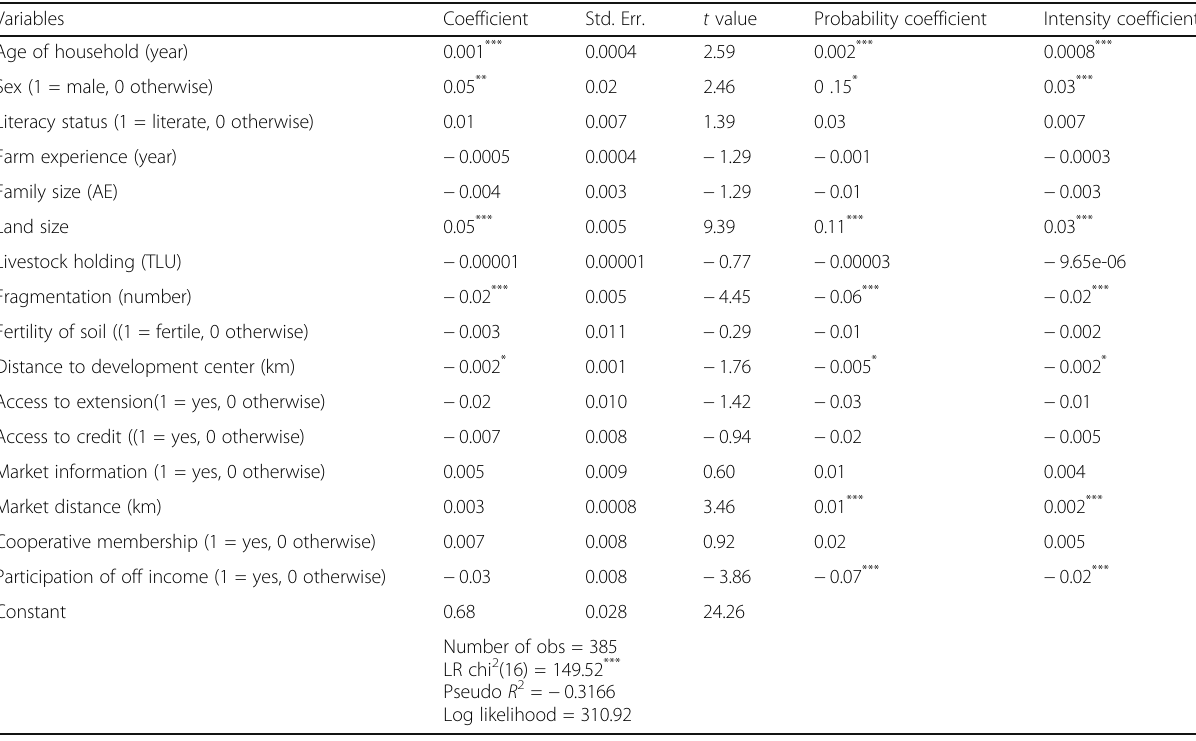
Table 2 Tobit regression result on status and intensity of crop diversification Variables Coefficient Std. Err. t value Probability coefficient Intensity coefficient